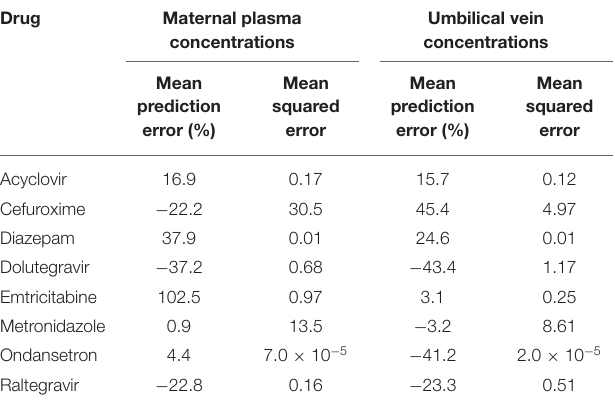
TABLE 4 | Mean prediction errors and mean squared